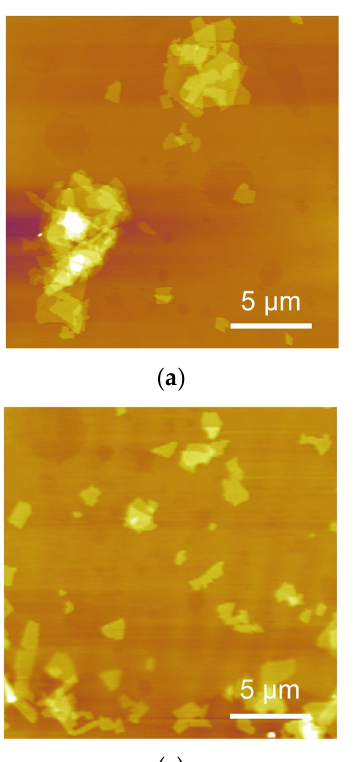
( c ) Figure 3. Characterization of SA/PEI dispersion with weight ratio of PEI to SA. ( a ) Zeta potential, ( b ) hydrodynamic size distribution and ( c ) average Zeta potential and hydrodynamic size of SA/PEI